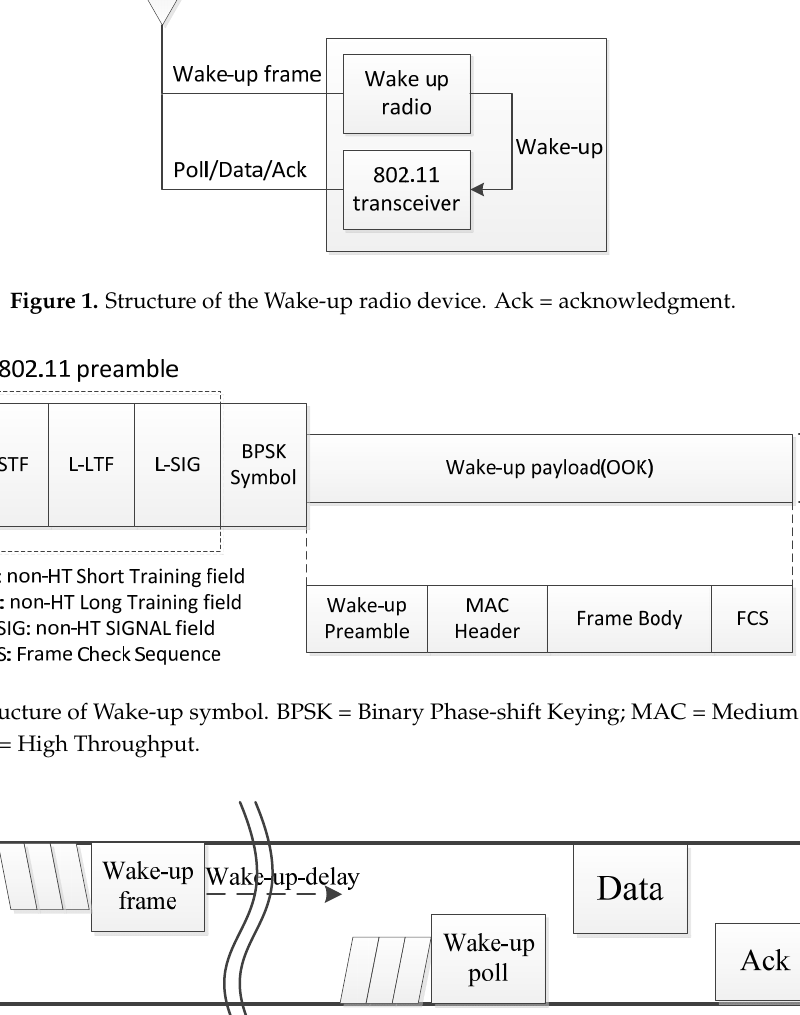
Figure 3. Wake-up radio transmission procedure in IEEE 802.11ba. STA = station; AP = Access Point.